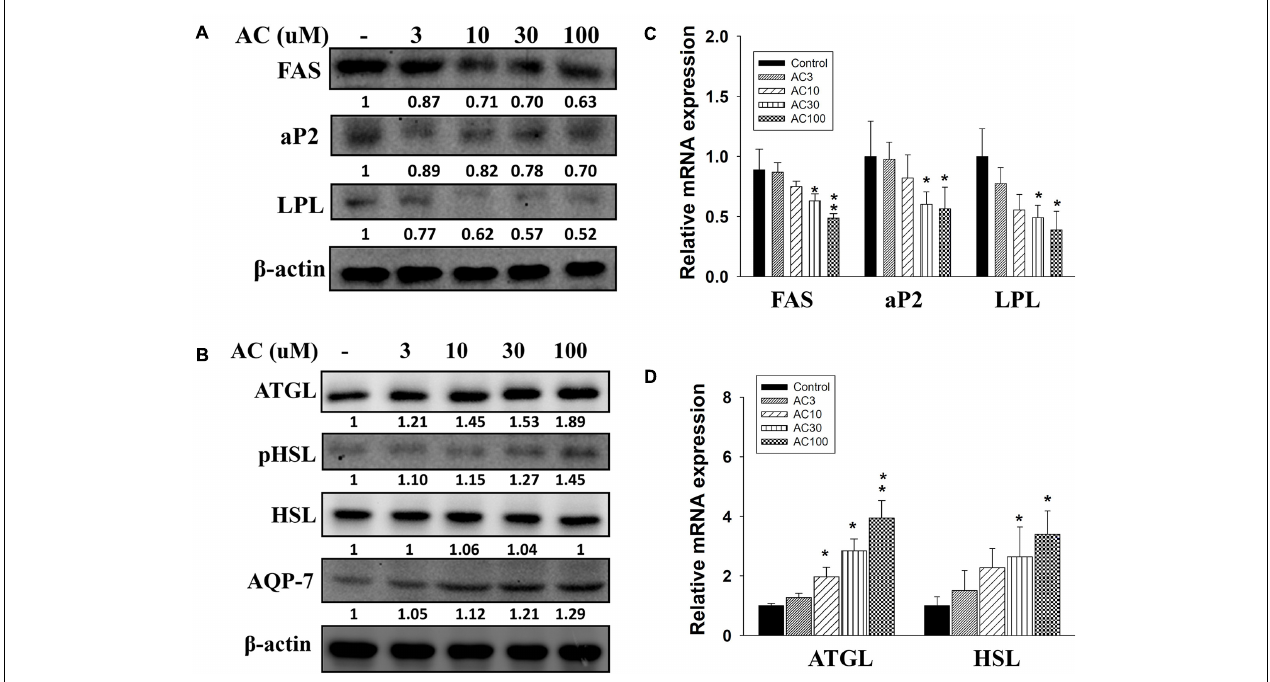
FIGURE 3 | The effect of acacetin (AC) (3–100 µ M) on the expression of proteins involved in adipogenesis and lipolysis in differentiated 3T3-L1 adipocytes. (A) The protein expression of FAS, LPL, and aP2 and the protein expression of (B) ATGL, phosphorylated HSL (pHSL), and AQP7 was determined using Western blot analysis ( n = 3 per group). β -actin was used as an internal control. (C) The gene expression of FAS, LPL, and aP2 and (D) the gene expression of ATGL and HSL was measured using real-time PCR. β -actin was used as an internal control. Data are presented as means ± SD. ∗ P < 0.05, ∗∗ P < 0.01 compared to differentiated 3T3-L1 cells (control group).